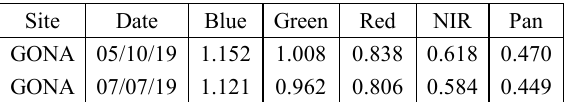
Table 4. Absolute gains estimated using acquisitions and field